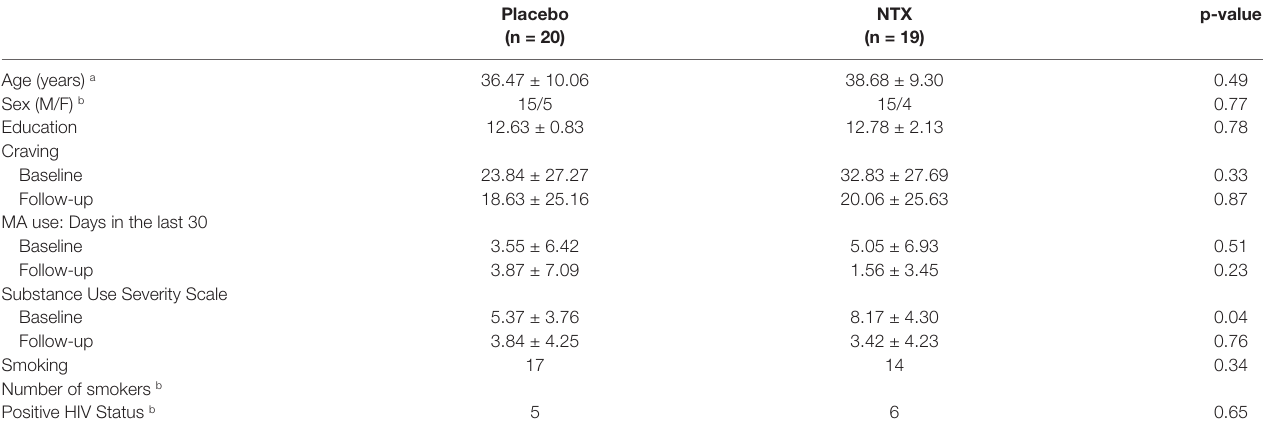
TABLE 1 | Participant